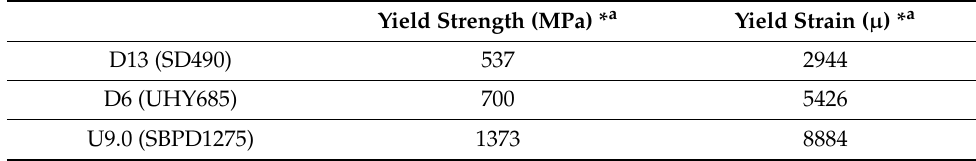
Table 2. Material characteristics of reinforcement.